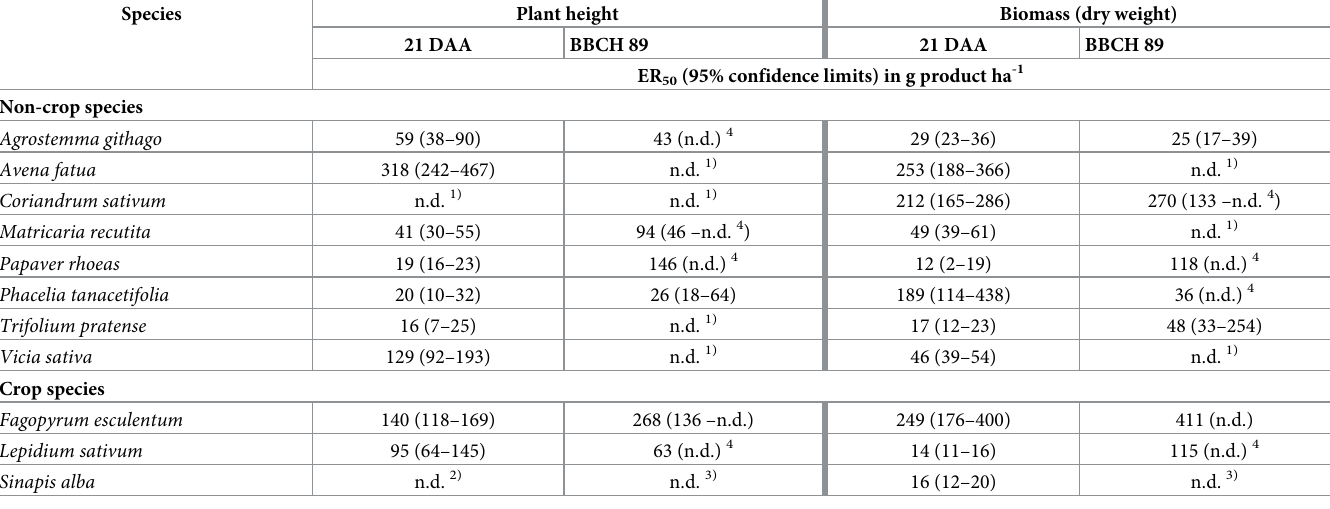
Table 4. Effect of Atlantis WG on plant height and biomass (expressed as ER 50 (with 95% confidence limits) recorded at 21 DAA (vegetative growth phase) and fully ripe stage of the plants BBCH 89 (generative growth phase) of the study. Species